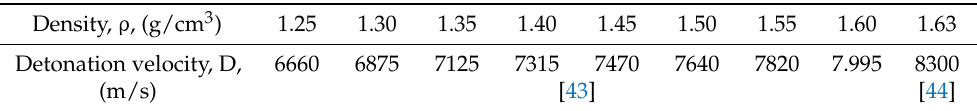
Table 8. Detonation wave propagation velocity of A-IX-1 explosive composition in function of its density